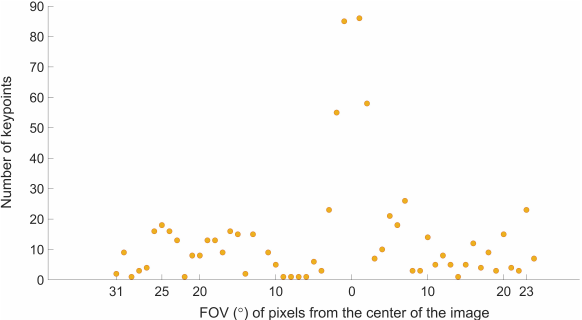
Figure 9. Keypoints detected at 1º variation across the FOV for the image acquired at 6m and ψ = 39.4286º